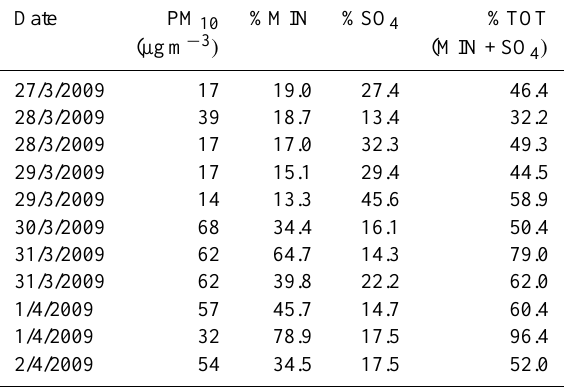
Table 2. Percentage of mineral dust (MIN) and sulfates contribu- tion in PM 10 (27/03-02/04) (Remoundaki et al., 2011): time-height cross section of the range-corrected backscatter lidar signal (in arbi- trary units: AU) at 1064nm, as observed over Athens, by the NTUA Raman lidar system on 2 April 2009